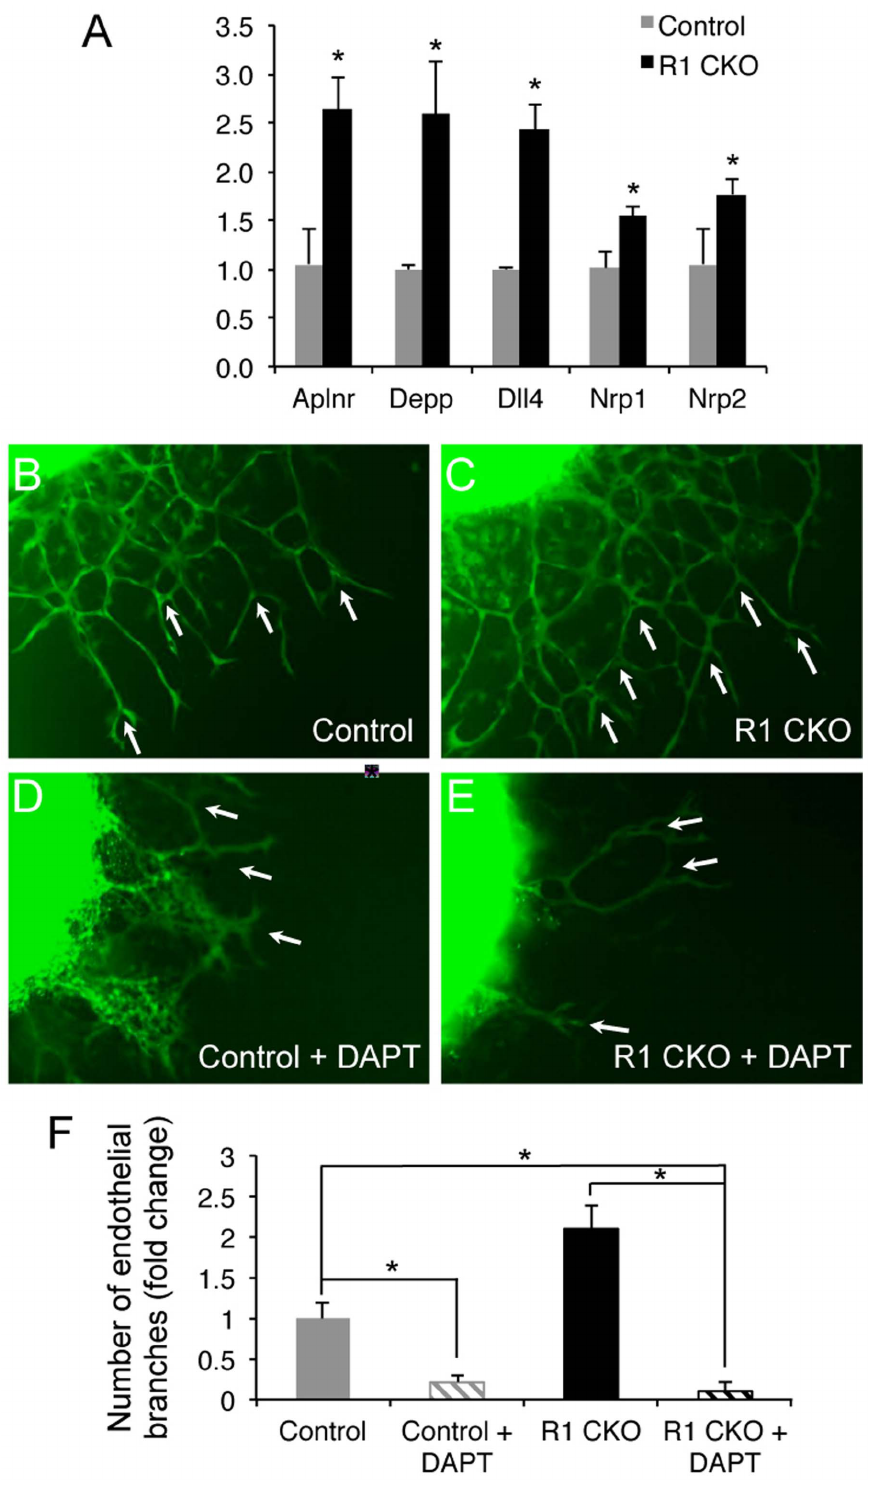
Figure 7. Notch signaling mediates Vegf 120 -induced coronary angiogenesis by the ventricular endocardial cells. A. A graph showing increased expression of 5 angiogenic/vascular endothelial genes in the E11.5 R1 CKO hearts. B-E, Images of E11.5 ventricular explants showing that Notch signaling inhibitor DAPT abolished the Vegf120-induced angiogenic branching (arrows) by the control ( B , D ) and R1 CKO endocardial cells ( C , E ). F, Statistical analysis showing that DAPT treatment significantly inhibits the endothelial branching by the control or R1 CKO endocardial cells. n =5 ventricles, * p , 0.05, error bars=SD.